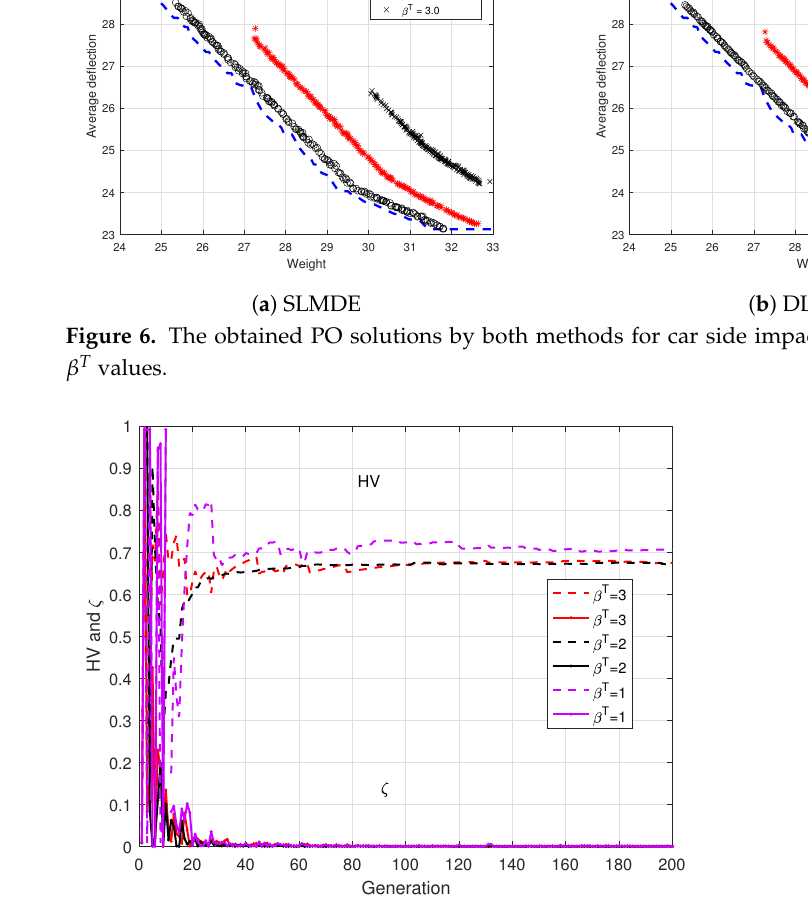
Figure 7. Progress of hypervolume and ζ of SLMDE with respect to number of generations for car side impact